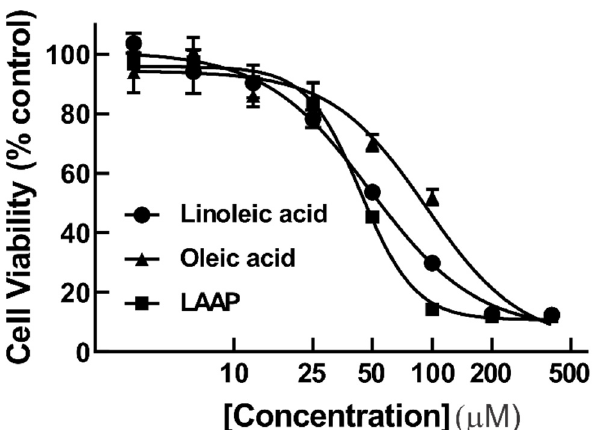
Figure 5. The linoleic acid, oleic acid, and LAAP mixture exhibited antiproliferative activity against HeLa cells. HeLa cells were treated with the linoleic acid, oleic acid, and LAAP mixture for 48 h at 400, 200, 100, 50, 25, 12.5, 6.25, and 3.125 µM. Cell viability was determined using the MTT assay. The result shown is representative data from three biological replicates ( n = 3). Error bars indicate standard deviation